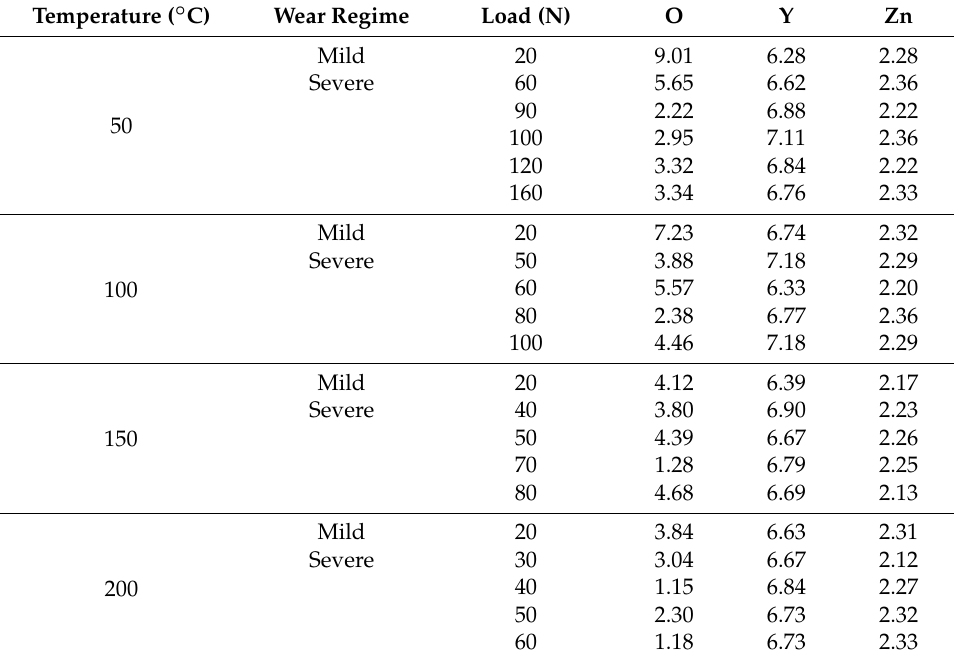
Table 2. Chemical composition of worn surfaces at 3.0 m/s